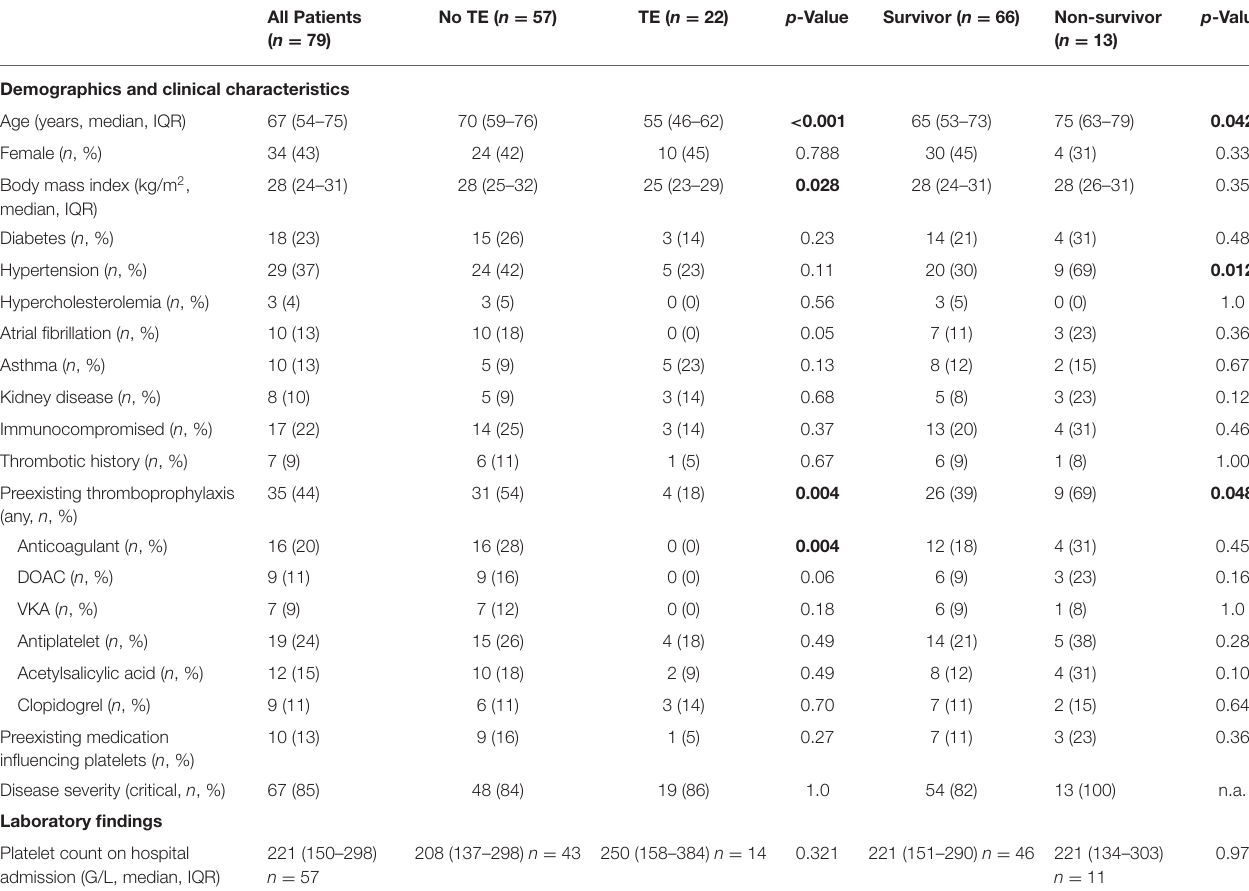
TABLE 1 | Patient demographics, clinical characteristics and laboratory findings.